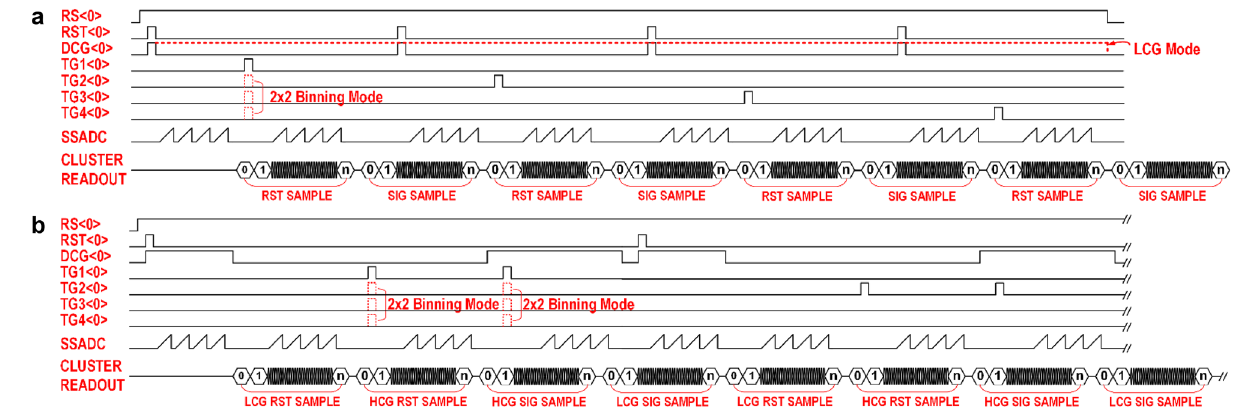
Figure 2. Illustrations of the operating timing of the QIS. ( a ) Simplified sensor operating timing diagram for the single-pixel-gain readout mode. In this example, CMS-4 readout is being used. ( b ) Simplified sensor operating timing diagram for the dual-pixel-gain readout mode. In this example, CMS-4 readout is being used.